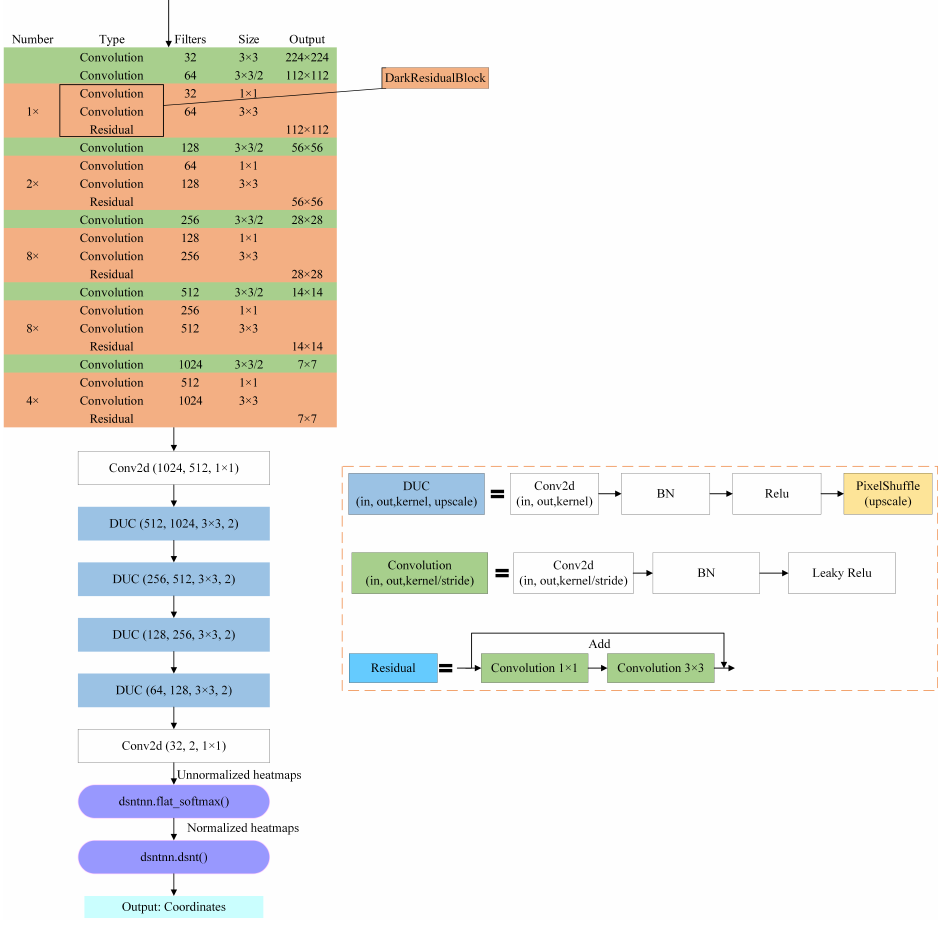
Figure 6. Darknet53-DUC-DSNT model structure for knob key point detection. The input image is extracted through Darknet53, upsampled through 4 DUCs, and finally returns key point coordinates through